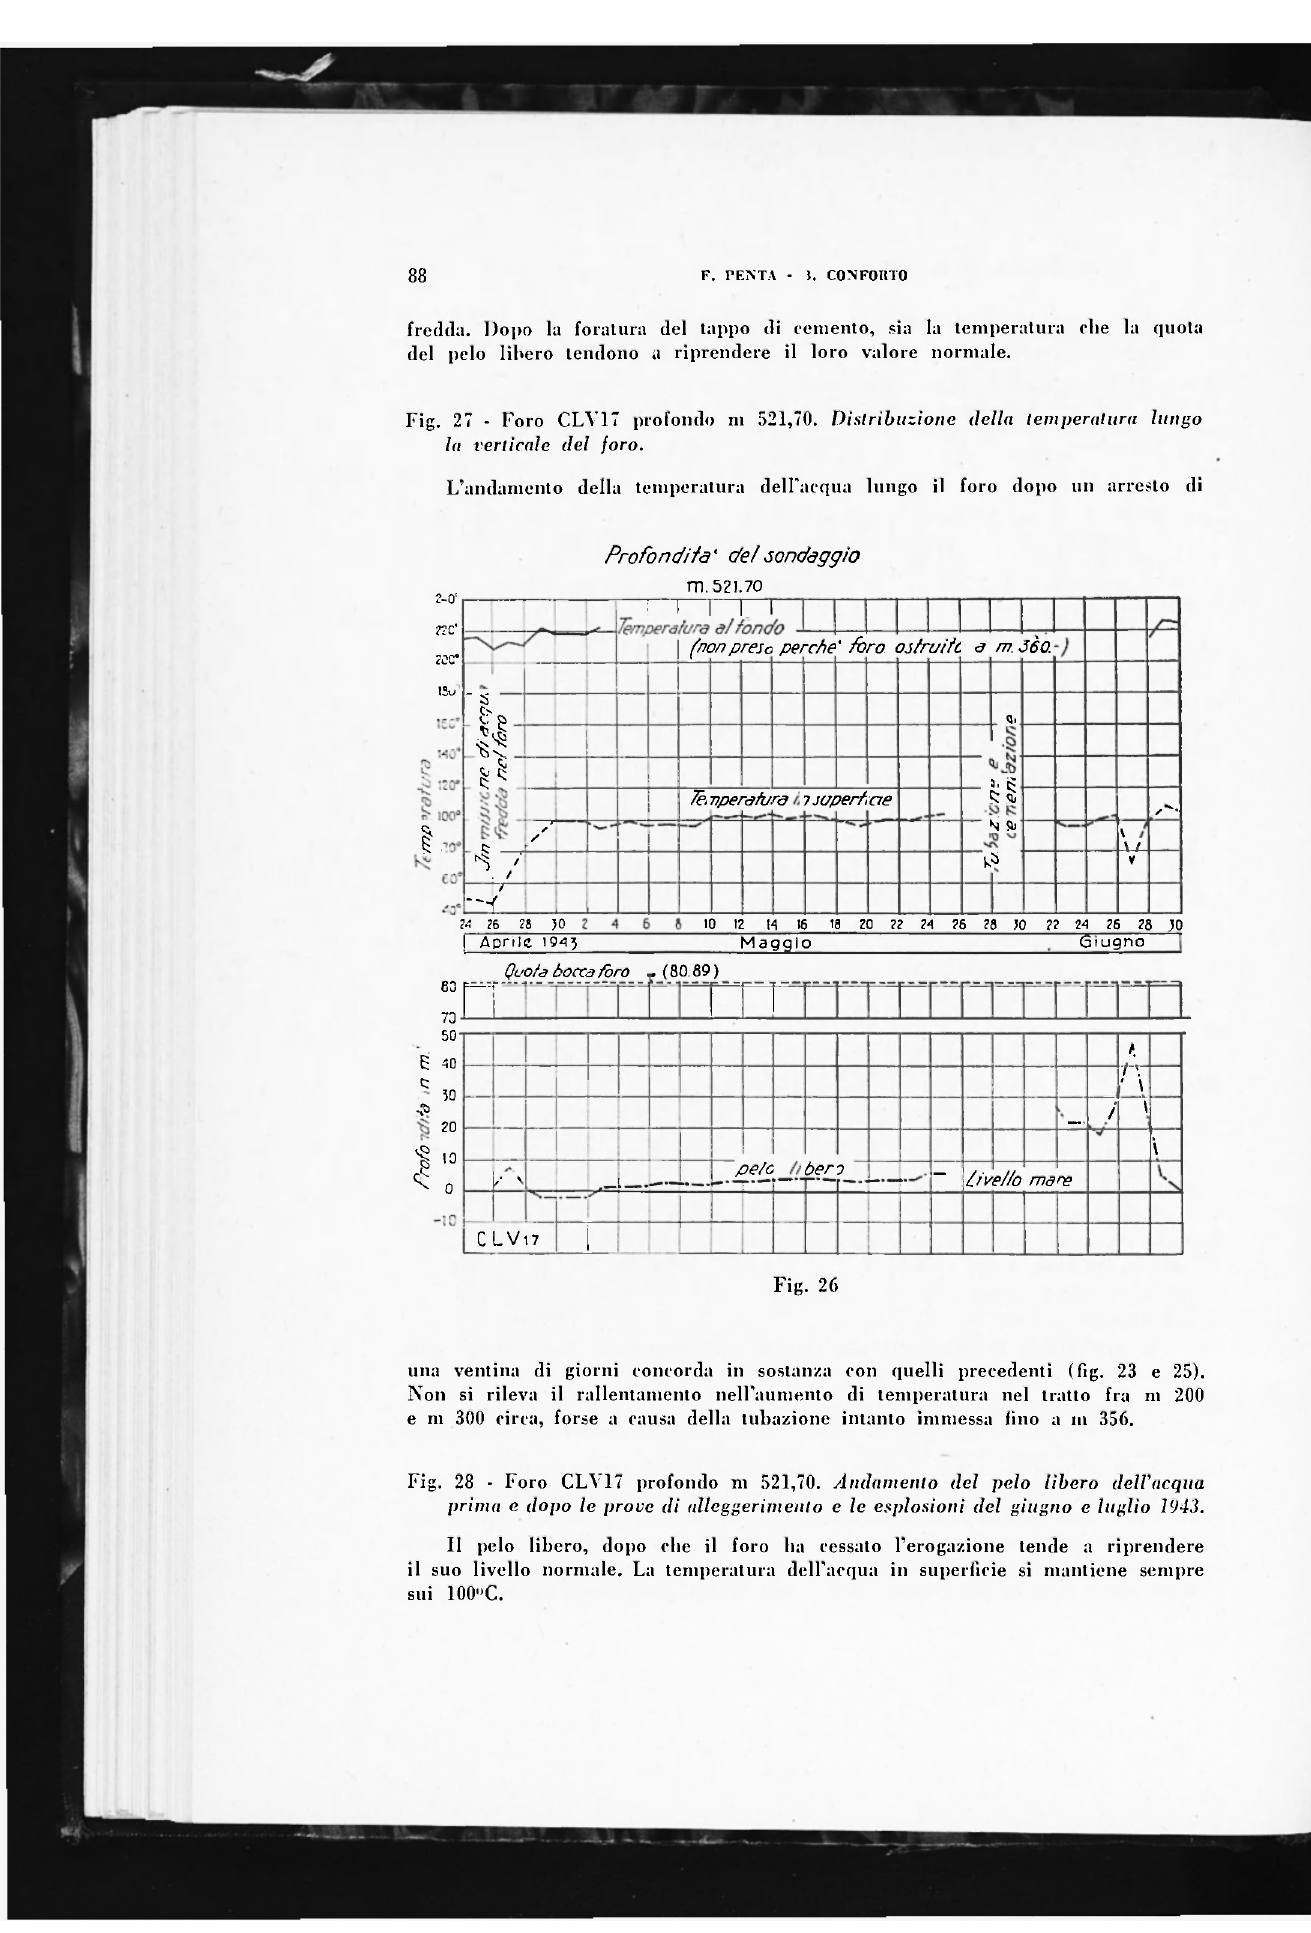
Fig. 28 • Foro CLV17 profondo m 521,70. Andamento del pelo libero dell'acqua prima e dopo le prove di idleggerimenlo e le esplosioni del giugno e luglio